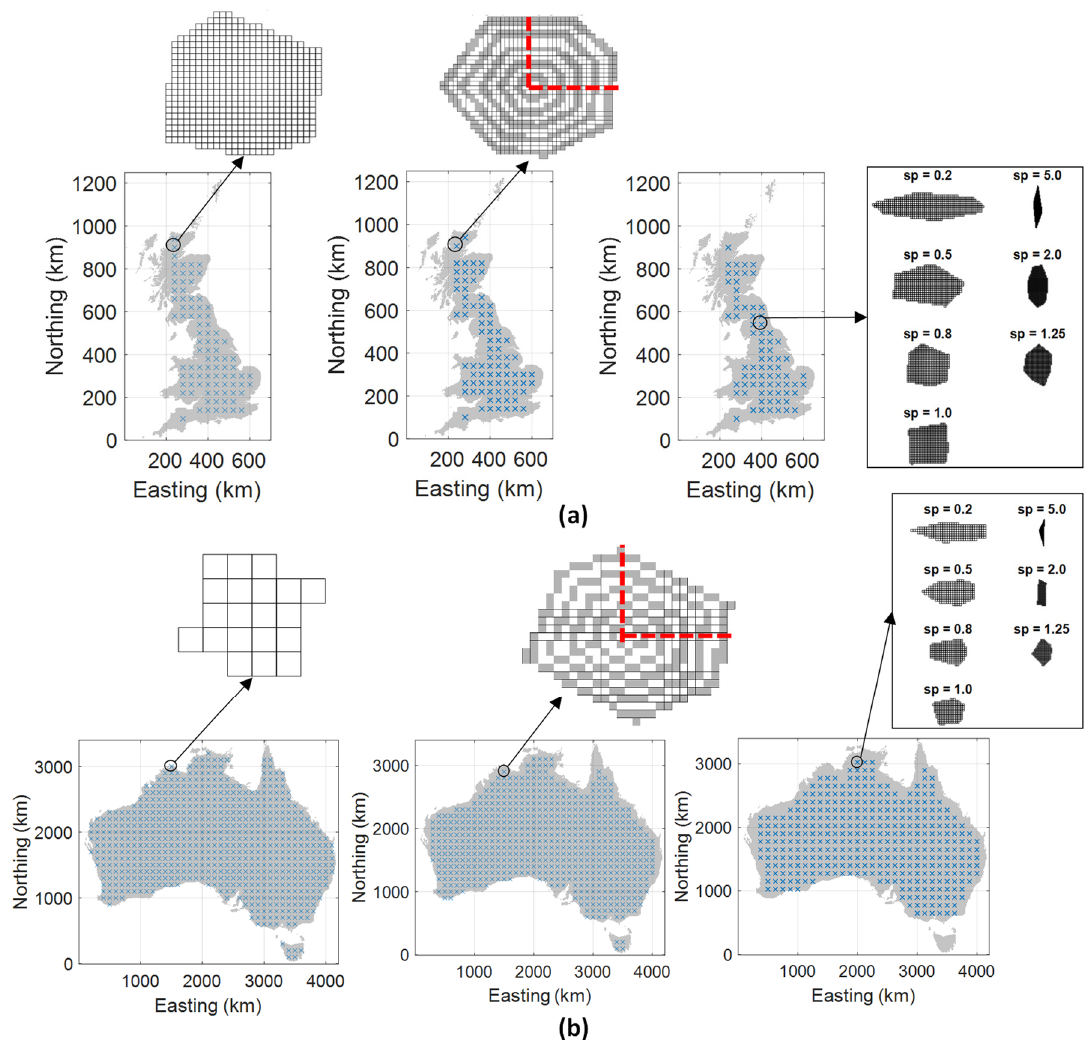
Figure 3. ROIs and their locations spatially distributed in GB ( a ) and AU ( b ) for this study: each subfigure can be divided into three panels where the left one demonstrates an ROI with the same size of 500 km 2 and a relatively rounded shape for the analysis in Section 3.1; the middle demonstrates a group of 10 ROIs which have a fixed shape but an incrementally increased size by defining an 20% increase in the main axis (marked as red dash line) in each iteration for the analysis in Section 3.2; the right panel depicts a group of 7 ROIs which have fixed size but varying shape described by spatial index sp . “ × ” marks the central location of these single or group of ROI(s) which are distributed uniformly over two countries. More details for generating ROIs can be checked in [20].